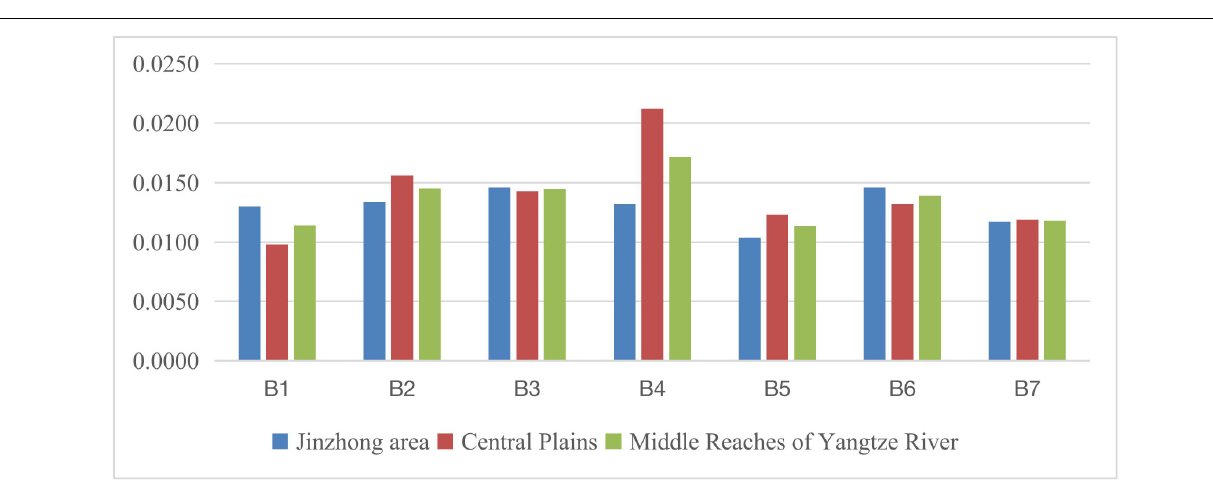
2016–2020, the data also shows that this gap has been